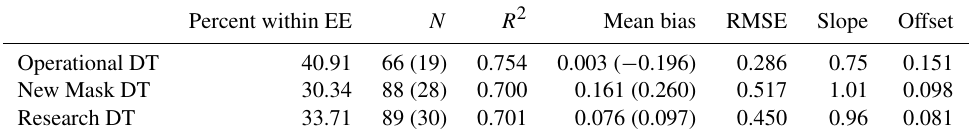
Table 2. Statistics of validation between operational DT AOD, AOD using the operational LUT but with new masks (New Mask), and Research AOD against AERONET during January, February, and March 2013 over China. Numbers in parentheses are the statistics for AERONET AOD > 1.